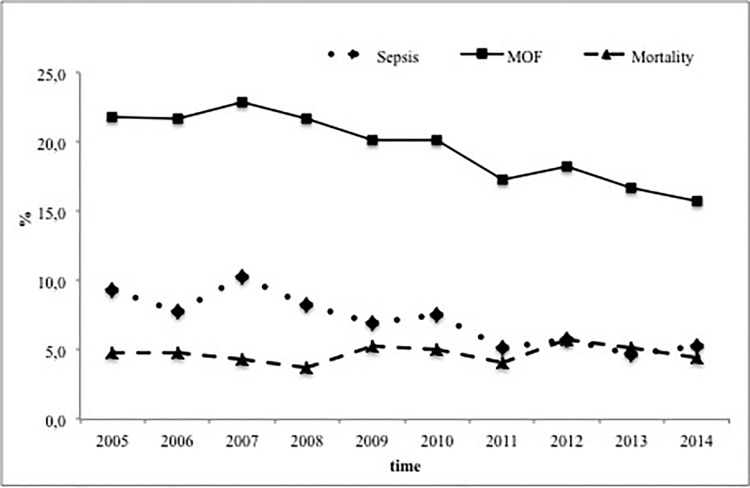
Significant decrease of sepsis, MOF and but not mortality rates between 2005 and 2014.